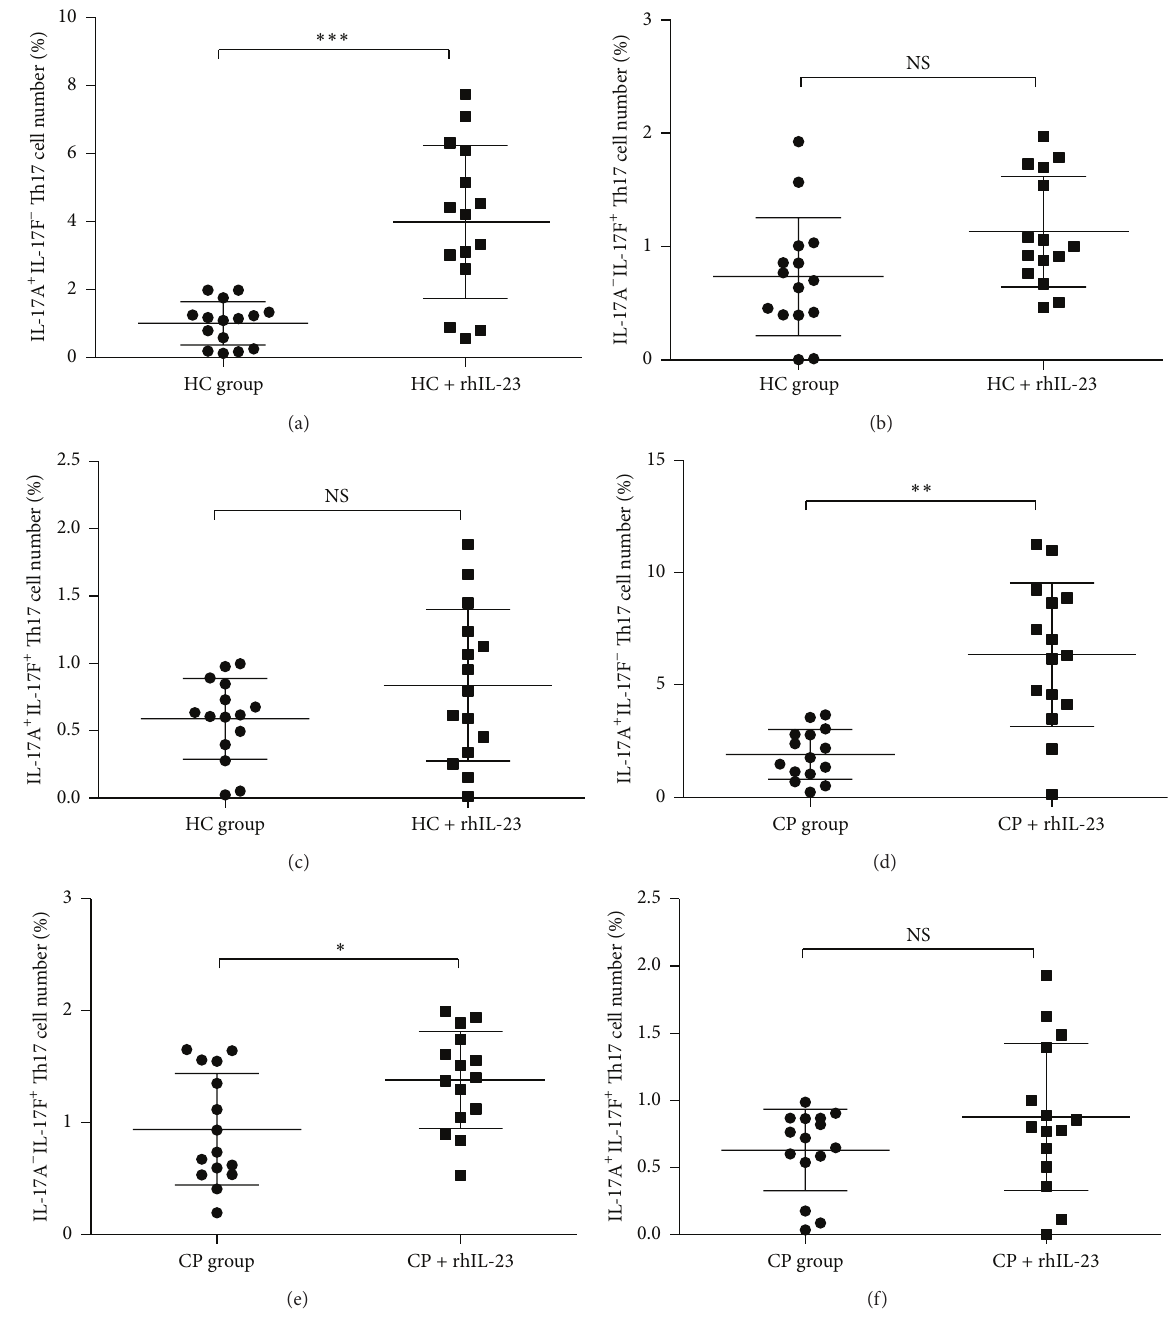
Figure5:StatisticalanalysisofIL-17A + andIL-17F + Th17cellsexpressioninCP( 𝑛 = 15 )andHCgroups( 𝑛 = 15 )withorwithoutrecombinant IL-23 stimulation. ((a) and (d) IL-17A + IL-17F − Th17 cell; (b) and (e) IL-17A − IL-17F + Th17 cell; and (c) and (f) IL-17A + IL-17F + Th17